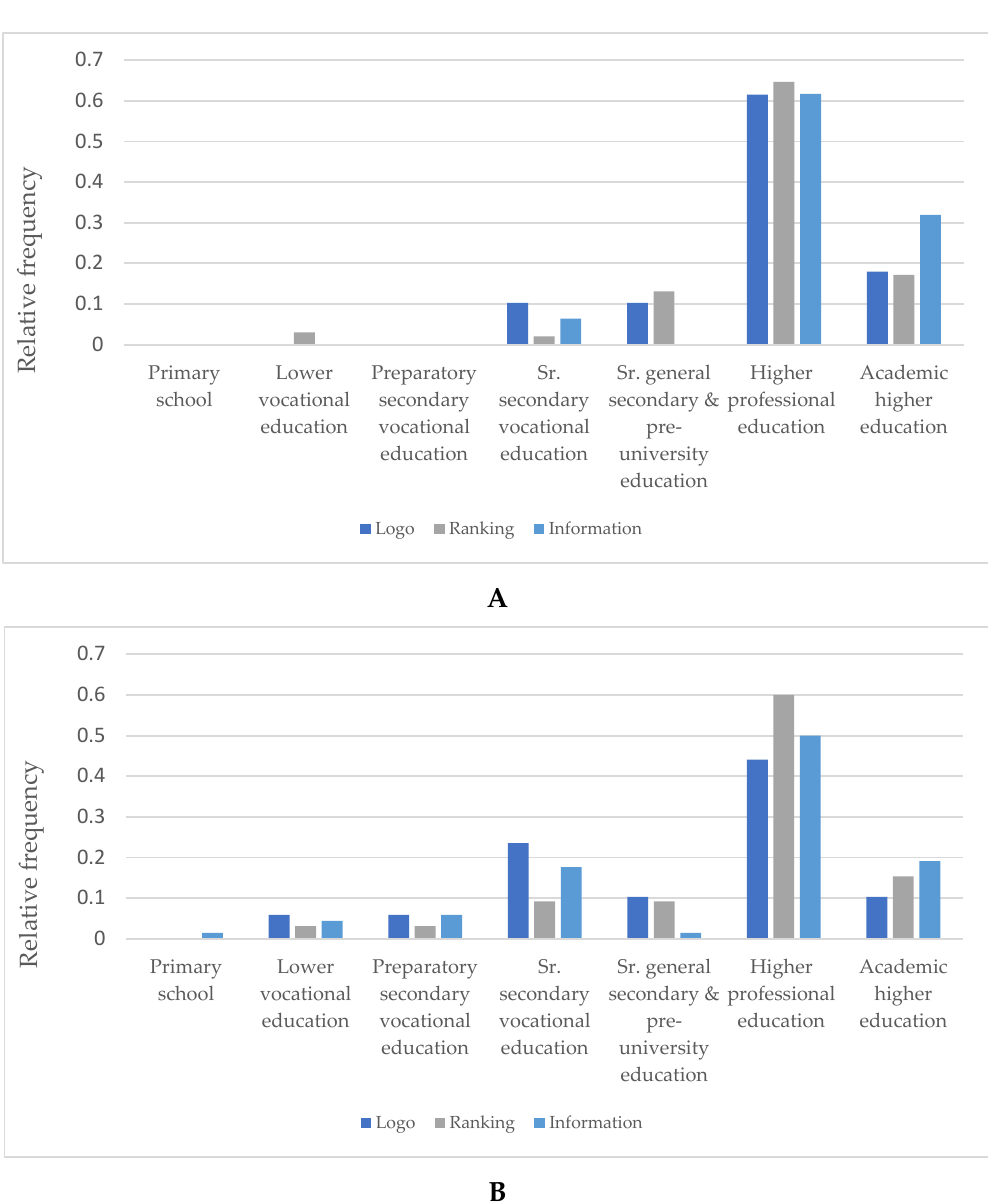
Figure 3. Relation of educational level of the (potential) restaurant guests with label preference (val- ues are represented as relative frequencies). Educational level ( p < 0 .001; χ2 -test goodness of fit) shows a relation with label preference.